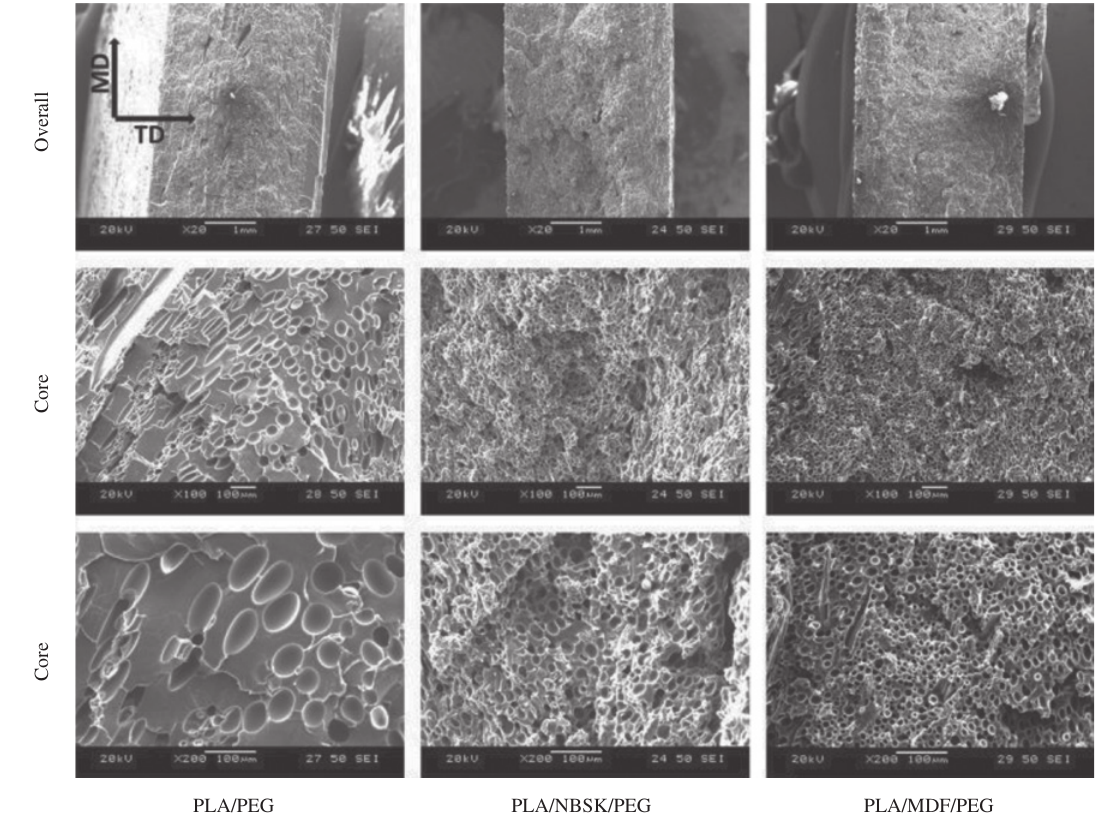
Figure 1: SEM micrographs of PLA/PEG, PLA/NBSK/PEG and PLA/MDF/PEG composite foams with 15% void fraction [43]. NBSK and MDF stand for two types of natural fibers. (© 2016 Elsevier